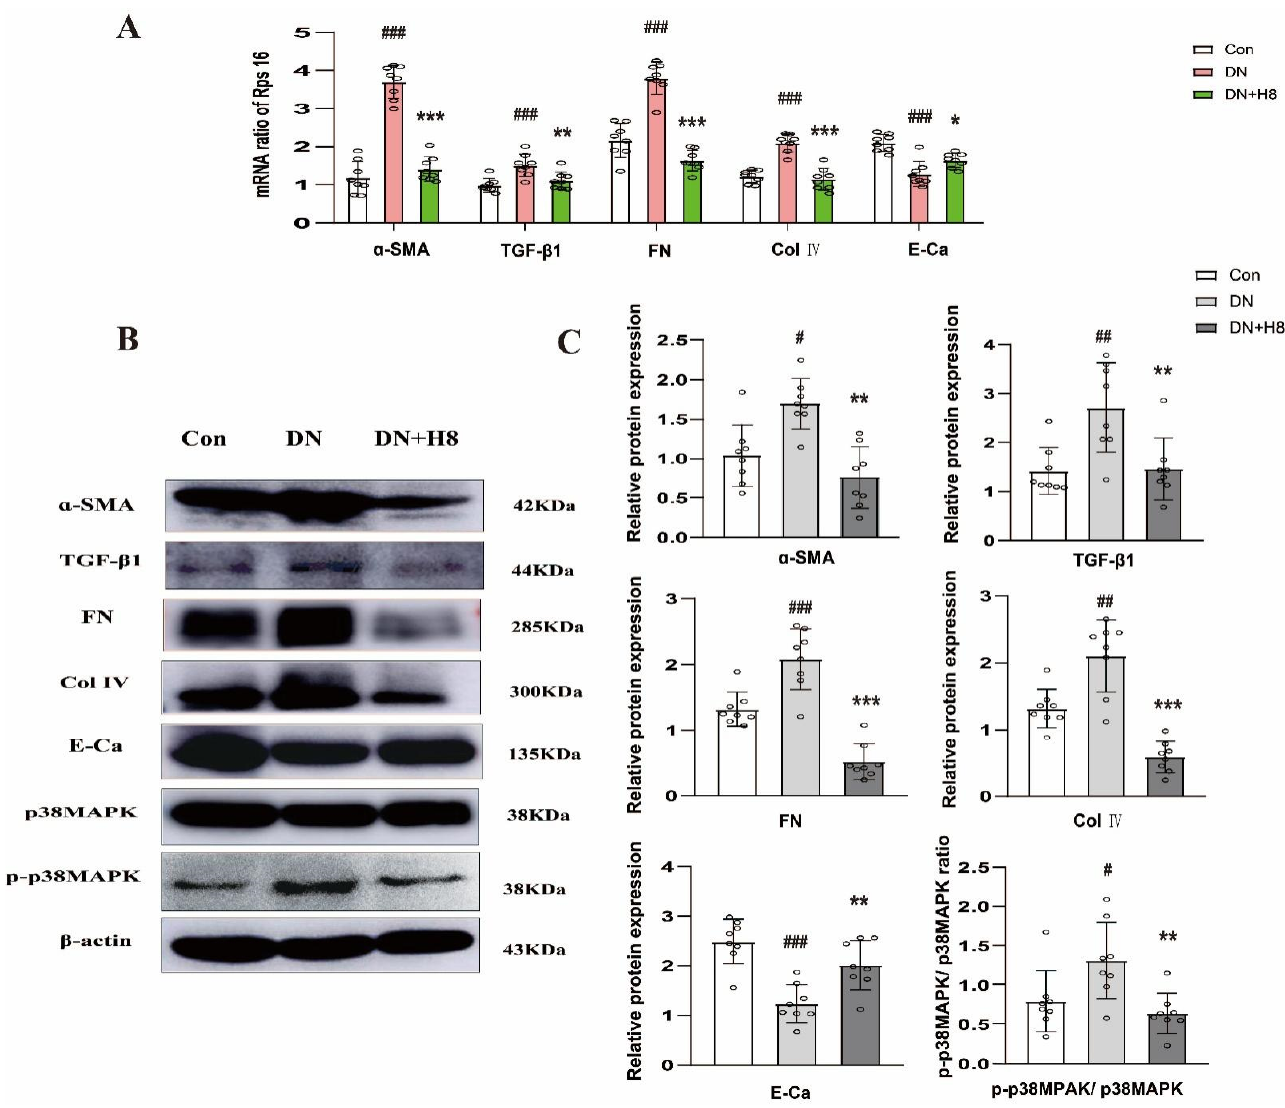
Figure 8. H8 repressed renal fibrosis and p38MPAK signaling pathway in DN rats. ( A ) The mRNA expression levels were examined by qPCR, and the values were normalized to rps16 ( α -SMA, TGF- β 1, FN, Col IV, and E-Ca). ( B ) Western blot band. ( C ) The protein relative expression levels ( α -SMA, TGF- β 1, FN, Col IV, E-Ca, and the ratio of P-p38MAPK/p38MAPK). Data are shown as mean ± S.D. ( n = 8/group). # p < 0.05, ## p < 0.01, and ### p < 0.001 compared to Con group; * p < 0.05, ** p < 0.01, and *** p < 0.001 compared to DN group.